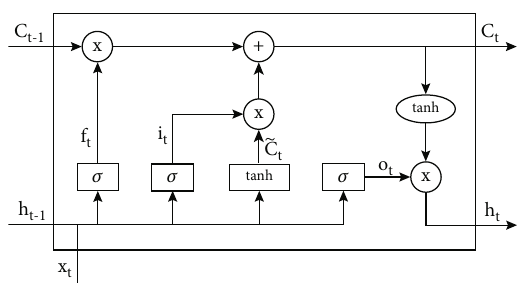
Figure 1: Long short-term memory Architecture